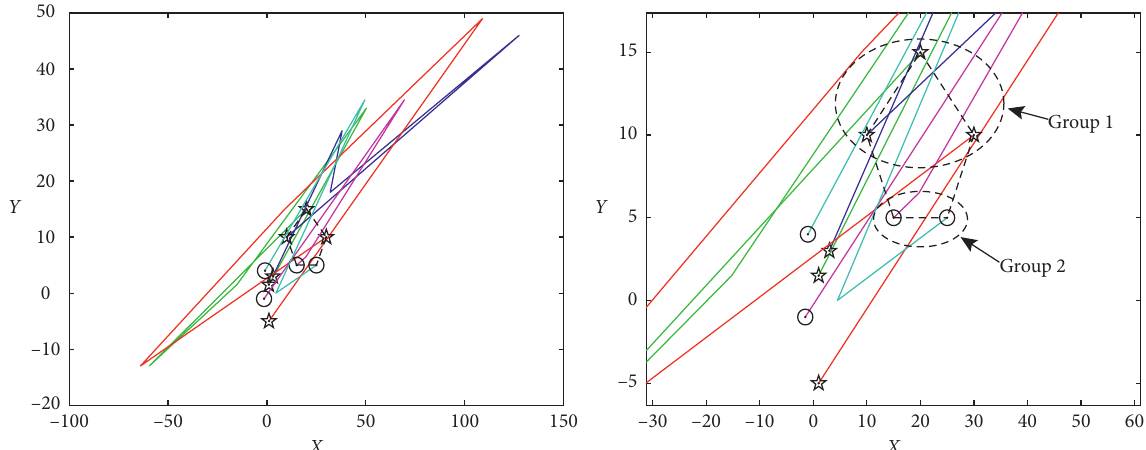
Figure 2: A regular pentagon array and its local magnification portion.